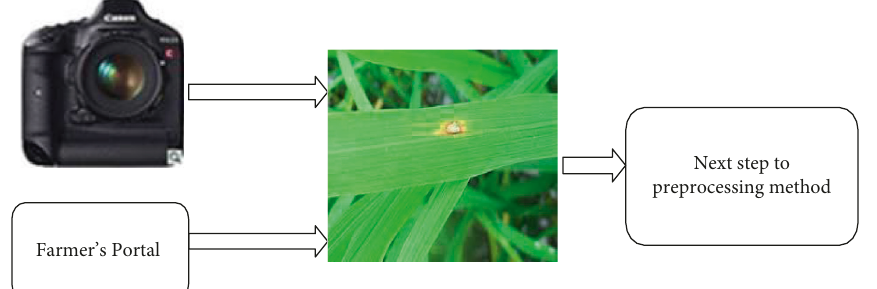
Figure 4: Structure of image acquisition.